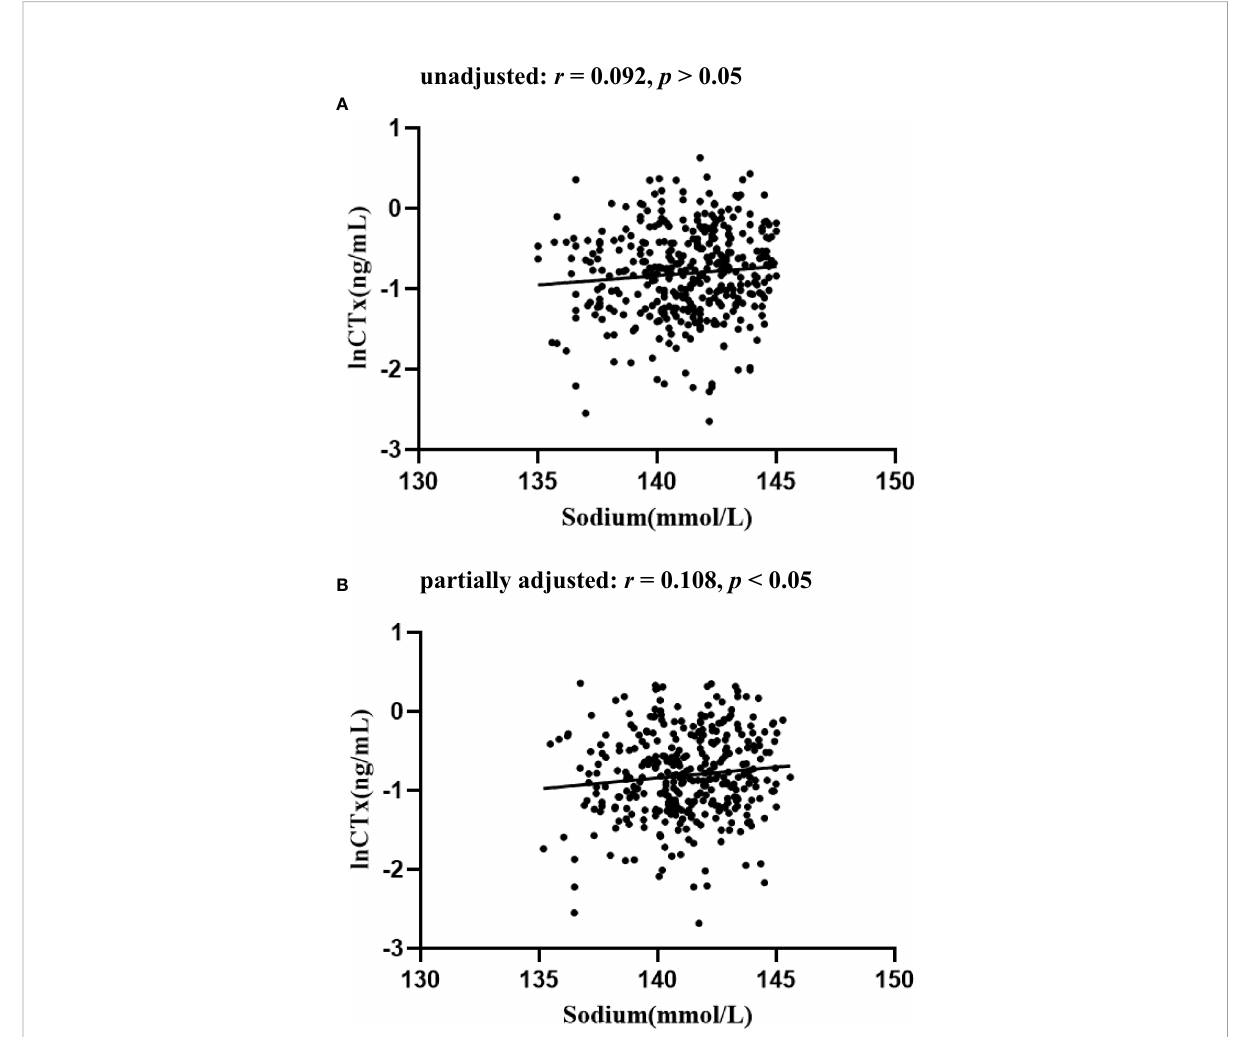
FIGURE 3 The relationship between serum sodium and lnCTx in patients with T2D (A) unadjusted; (B) partially adjusted for age, sex, BMI and HbA1